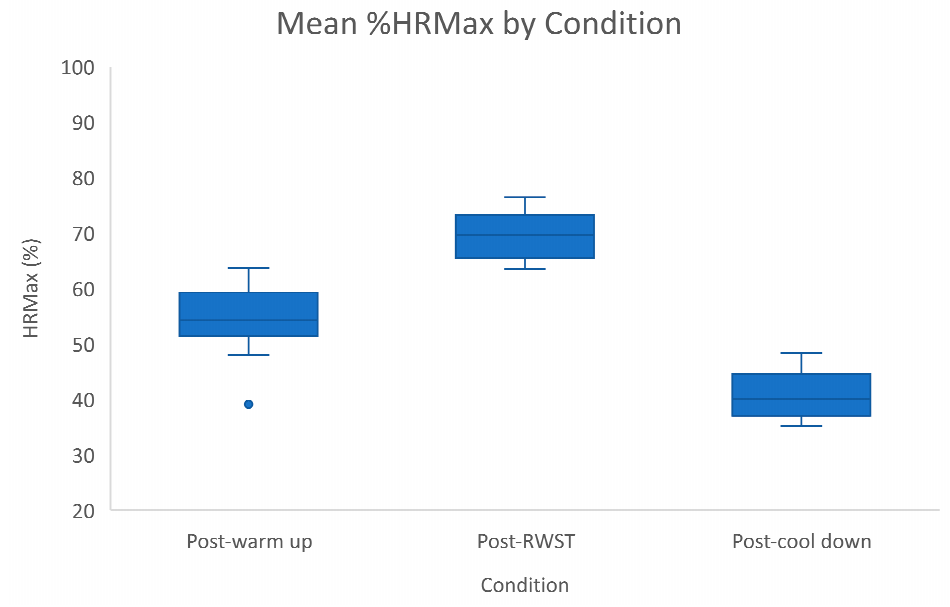
Figure 4. Mean %HR max by active condition—error bars represent standard deviation and isolated point represents outlier.